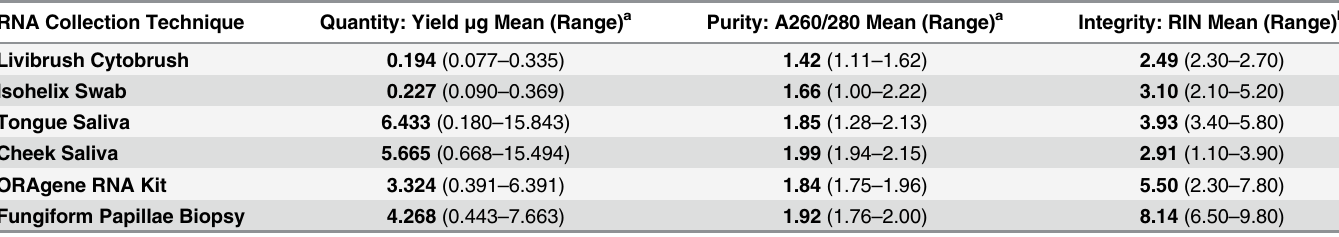
Table 2. Comparison of RNA quantity, purity and quality from the different collection techniques. RNA Collection